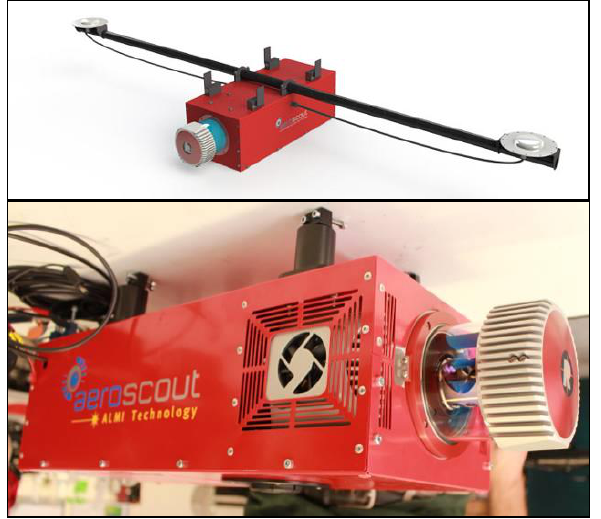
Figure 2: Airborne Laser Scanning and Monitoring Integration (ALMI) of a RIEGL VUX-1 laser scanner, full-frame photo camera, and two GPS antennas.